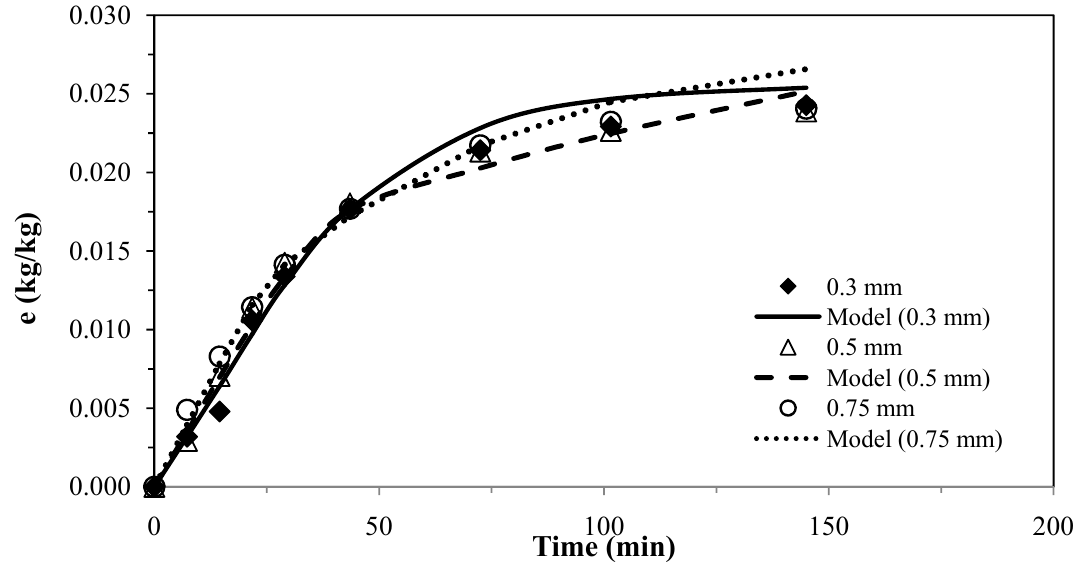
Figure 1. Pennyroyal essential oil yield for different mean particle size and and CO rate of 4.7 × 10 − 4 kg·s − 1 . Continuous curves from model, k k = 1.95 × 10 − 6 m·s − 1 . f